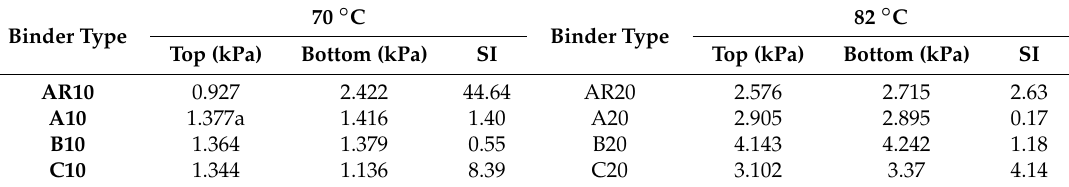
Table 8. Complex shear modulus and separation index of different asphalt binders at high critical temperature of AR.